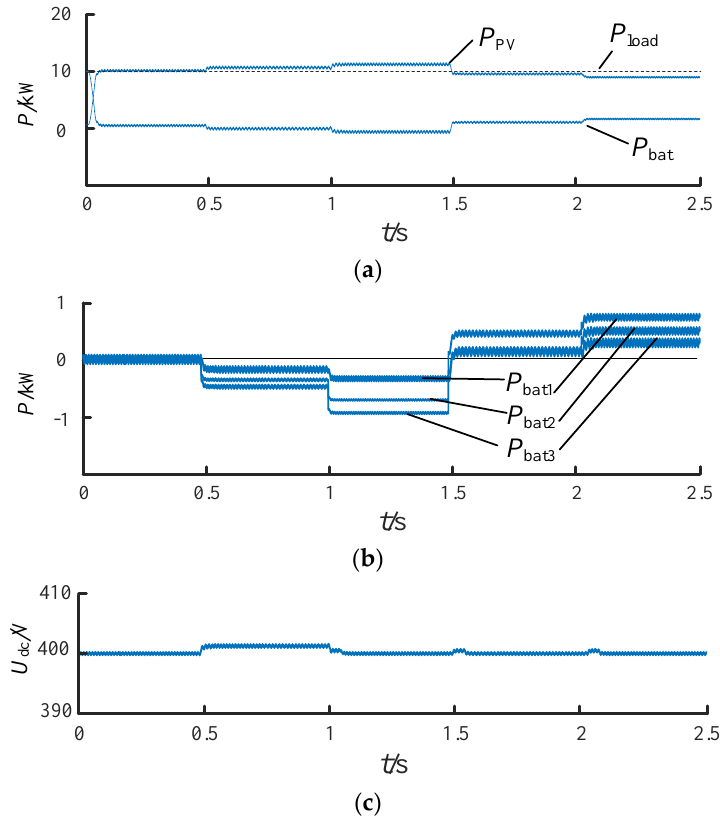
Figure 8. Simulation results of ESU not exceeding the limit. ( a ) Photovoltaic, load, and DESS power. ( b ) ESU output power. ( c ) DC bus